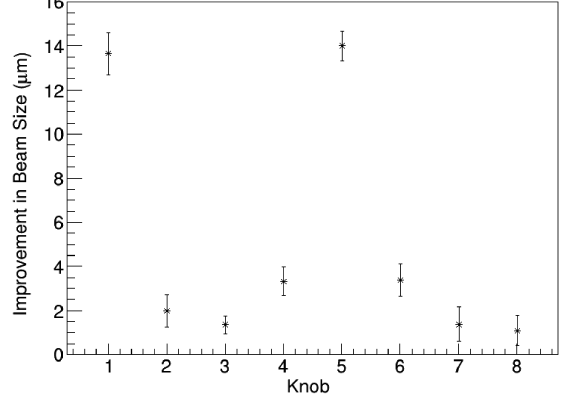
FIG. 7. The improvement due to each knob when tuning the real machine starting from a lattice without additional corrections. Knob 5 contributes a surprisingly large amount. However, we note that it needed to be turned more than twice as far as any other knob, and more than four times as far as the first knob, which suggests that its utility stems from the fact that, when tuning the lattice for use in light-source operations, the first few knobs had already been used, and so the fifth knob is the strongest knob to have not been well-tuned. Note that, when comparing to Fig. 3 or Fig. 4, the latter two plots show the beam size after tuning N knobs while this plot shows the change in beam size from tuning the Nth knob.